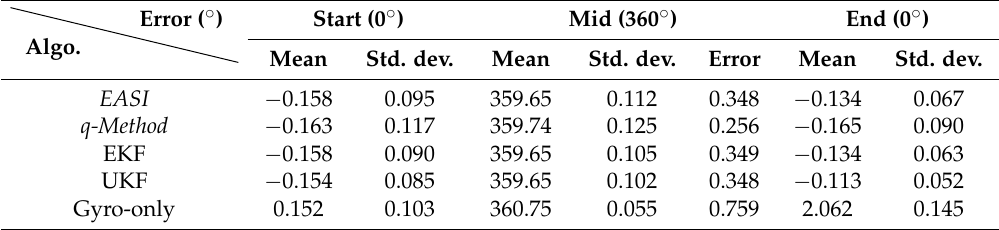
Table 3. Statistical comparison of heading estimation algorithms in the 1st TiP test (B-i).